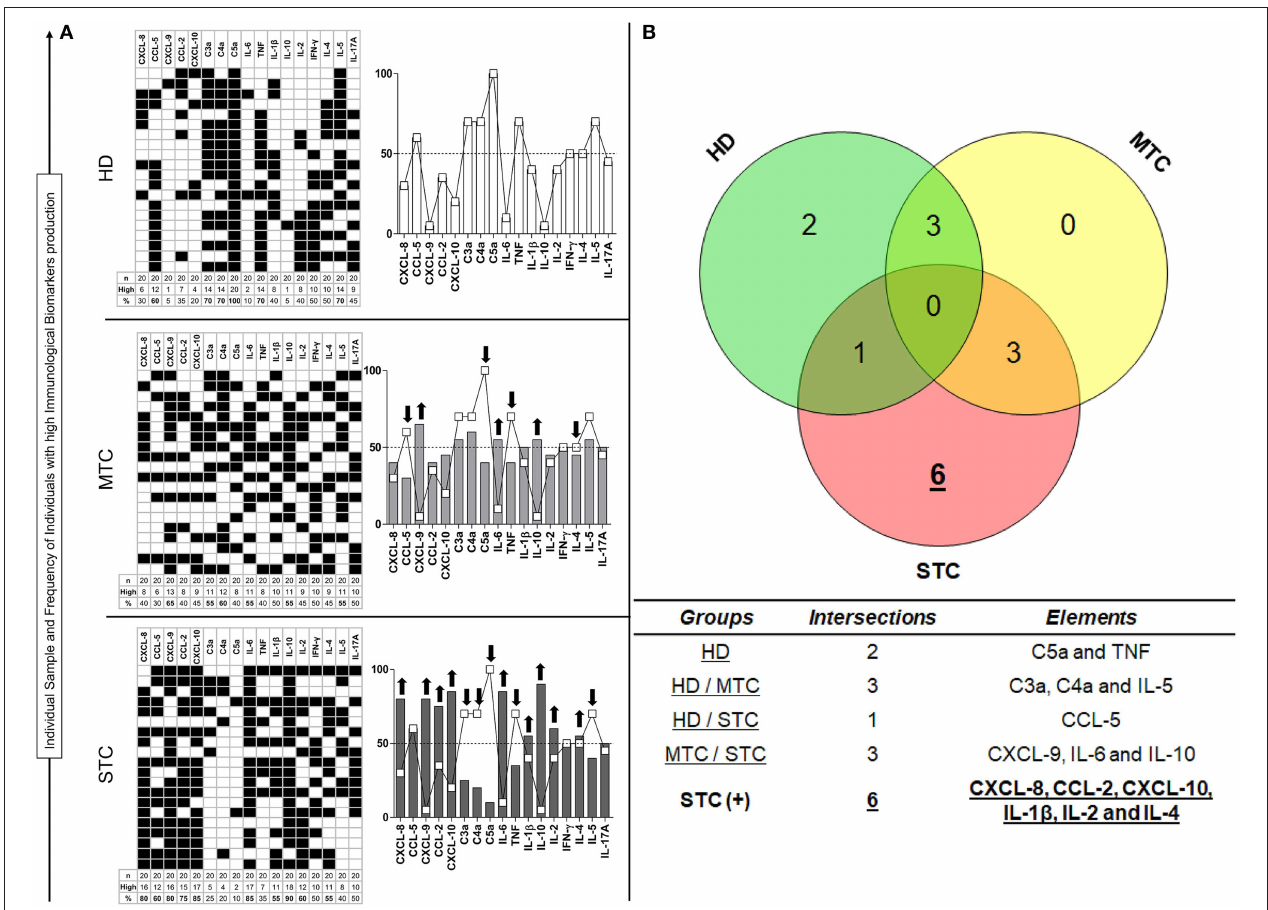
FIGURE 4 | Unconventional analysis for signature of biomarkers demonstrated in STC patients. This is shown on the basis of the total percentage of each group, in which molecules present higher production ( ↑ ) in each patient ( (cid:4) ), considering the clinical outcome (A) . In the Venn diagram, it is possible to identify which elements demonstrate themselves to be potential biomarkers by being present in high concentrations in the STC group only (B) . Immunological Soluble Molecules Level Quantification by CBA and ELISA. The global median for each immunological soluble molecule was employed as a cut-off point expressed in MFI to discriminate each individual as being a “Low” or “High” producer of the chemokines, anaphylatoxins, and cytokines summarized in the grayscale